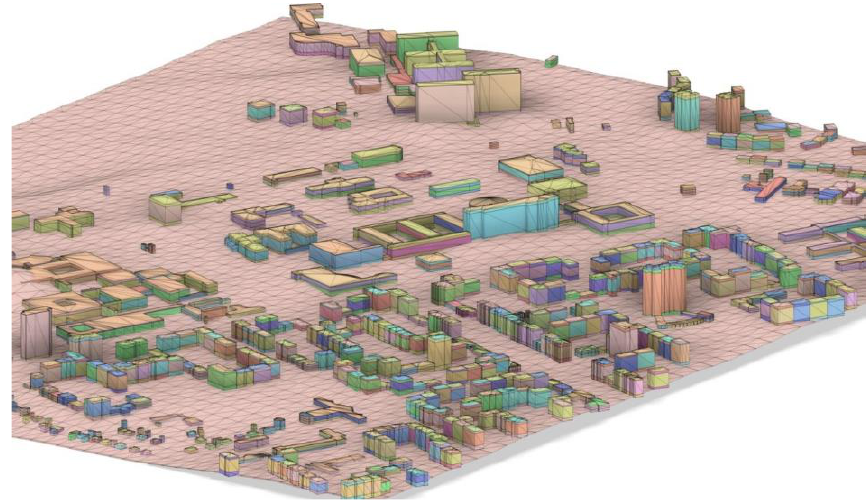
Figure 1. Example — Section of the “ cleaned ” model of part of Ostrava for subsequent simulations Figure 1. Example—Section of the “cleaned” model of part of Ostrava for subsequent simulations (source: authors). (source: